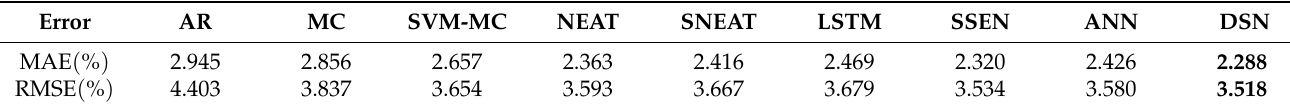
Table 2. Forecast under different models over all ramps of the year